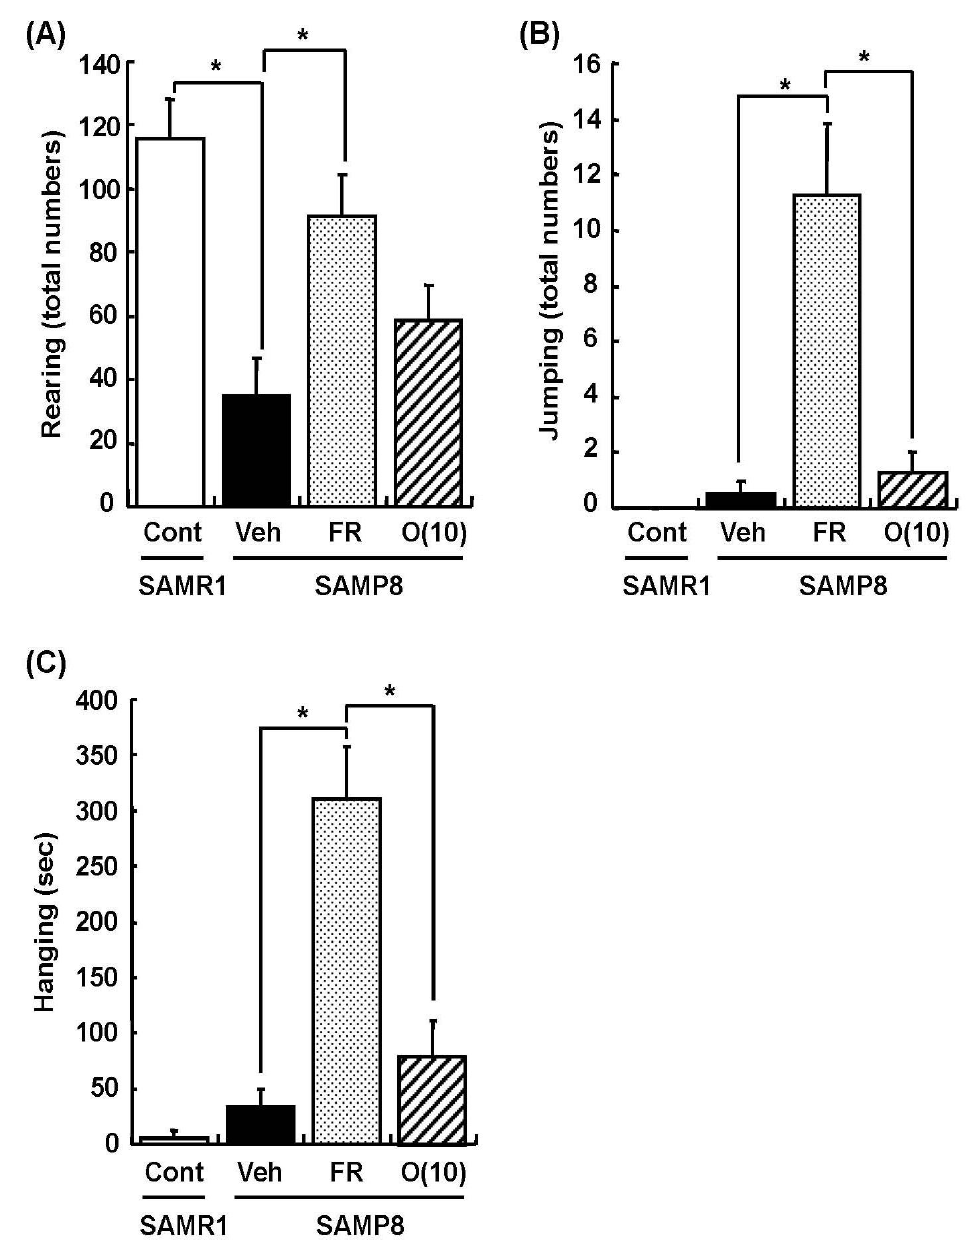
Figure 4. Effects of oligomers on stereotypical behaviors. Forty-five or forty-six-week-old SAMP8 mice were administered vehicle (Veh, water p.o., n = 4), while another two groups were administered oligomers orally at doses of 10 mg/kg body weight/day (O (10), n = 4) using a stomach tube until death. For the remaining group of mice, the mean food intake was restricted to 60% until death (FR, n = 4). SAMR1 mice (Cont, 45–46 weeks old, n = 4) were used as a control group. One hundred and thirty-nine days after the start of administration, actions of rearing up on the hindlimbs and jumping from the bottom of the cage were counted for 15 min ( A , B ). The time spent hanging from the lid was measured for 10 min ( C ). Administration was continued during the tests. a p = 0.0034 (Student’s t -test); * p < 0.05 (One-way ANOVA, post-hoc Bonferroni’s